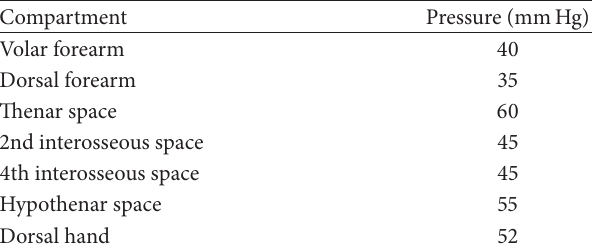
Table 1: The patient’s measured compartment pressures. Only representatives of the compartments were